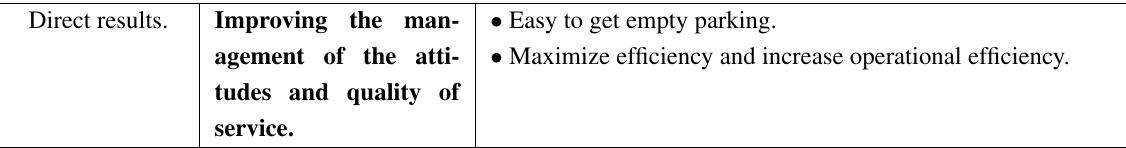
Table 1. Results of PGIS system, the positive effects (Adeeb, 2016) Direct